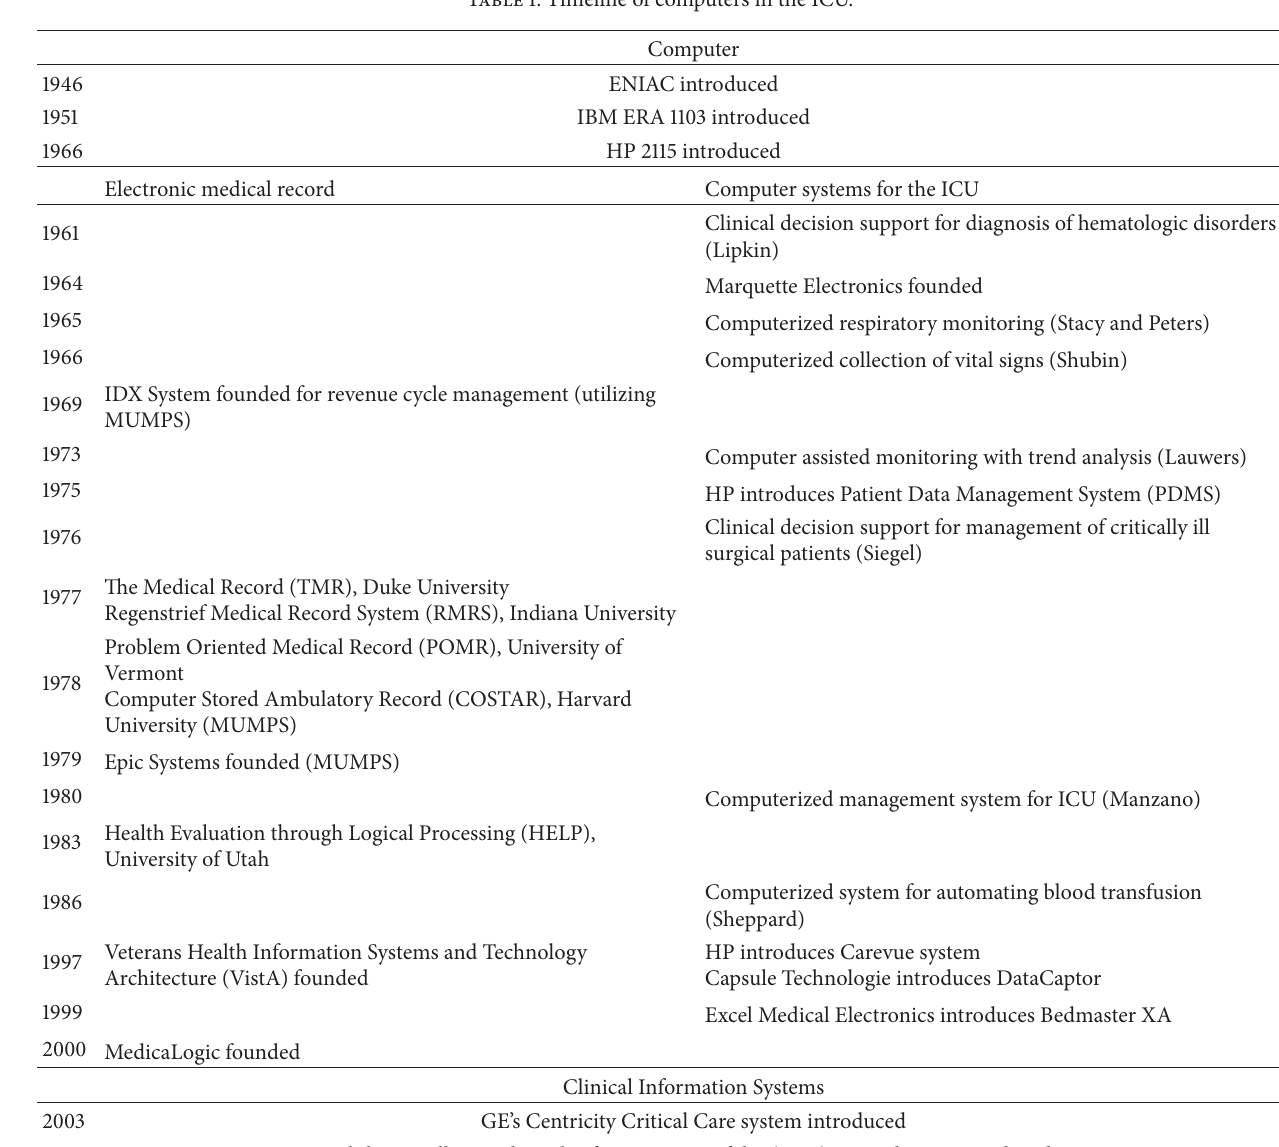
Table 1: Timeline of computers in the